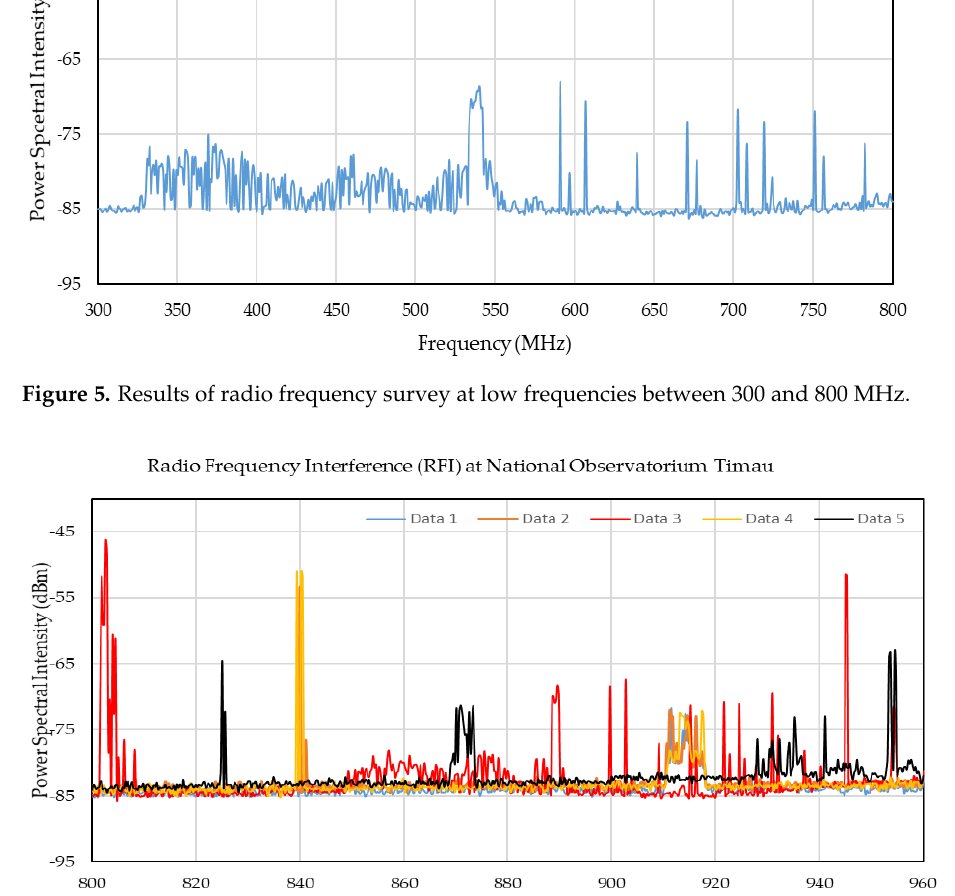
Figure 5. Results of radio frequency survey at low frequencies between 300 and 800 MHz.